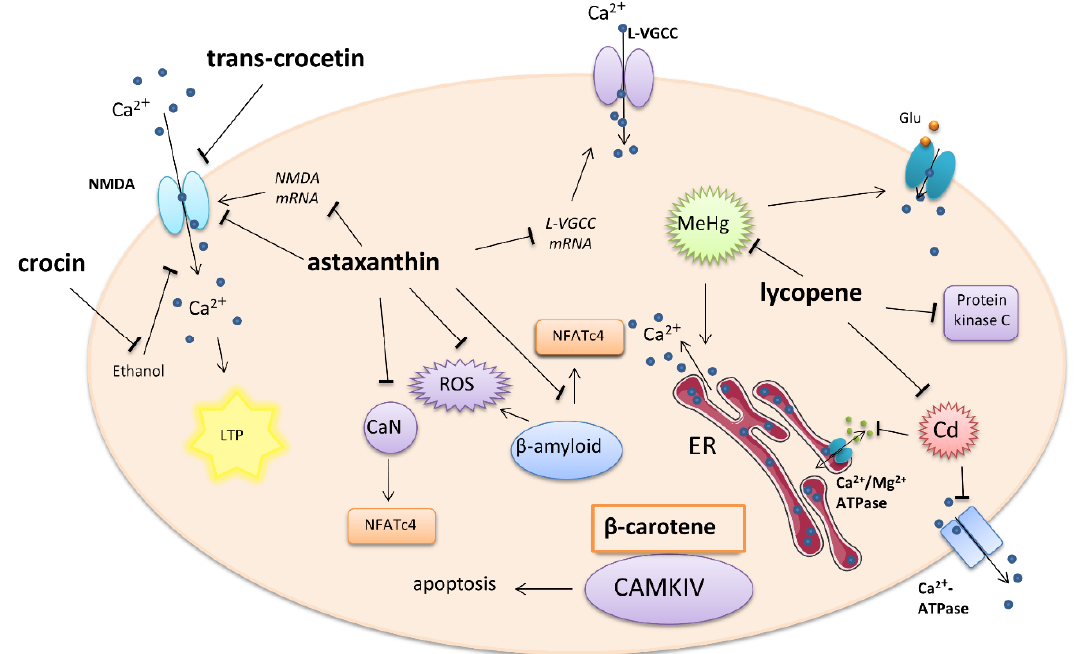
Figure 1. Effect of carotenoids on intracellular calcium-involved actions. Arrows—stimulation or calcium influx/efflux; T-bars—inhibition of pathway; ER—endoplasmatic reticulum, Glu—glutamate